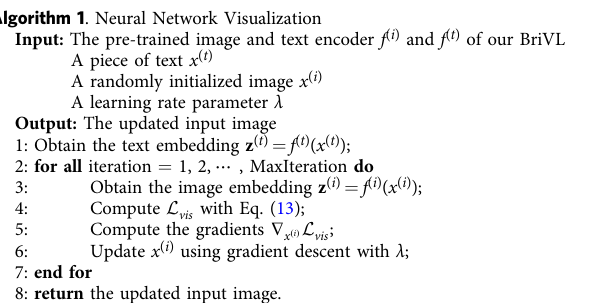
Algorithm 1 . Neural Network Visualization Input: The pre-trained image and text encoder f ( i ) and f ( t ) of our BriVL A piece of text x ( t ) A randomly initialized image x ( i )